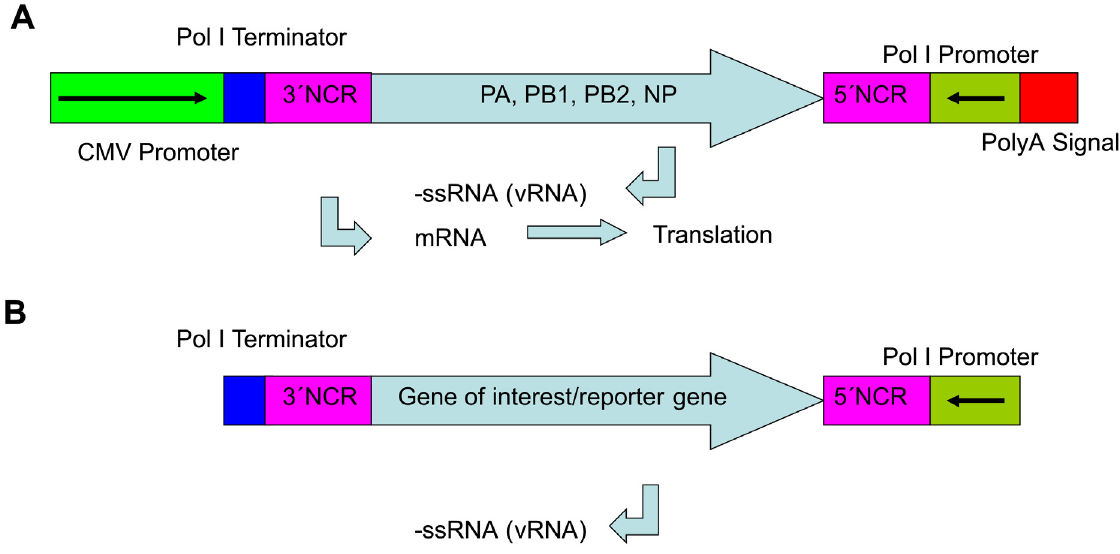
Figure 2. Schemata of bidirectional and monodirectional transcription cassettes. Bidirectional cassettes (A) were used for generation of the influenza replicon. Monodirectional cassettes (B) were used to generate vRNA of reporters or genes of interest.